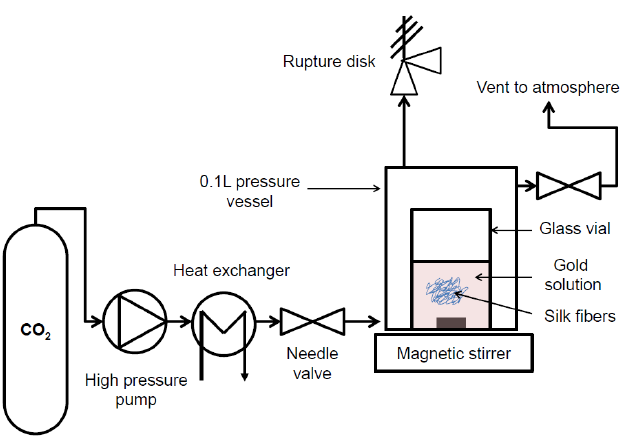
Figure 1. Schematic diagram of supercritical CO 2 set up. Briefly, when reaching supercritical conditions, the water and gold NPs become a ternary mixture of water/gold NPs/scCO 2 . The new mixture has enhanced diffusion and interfacial properties allowing the gold NPs to be transported in the fibers.